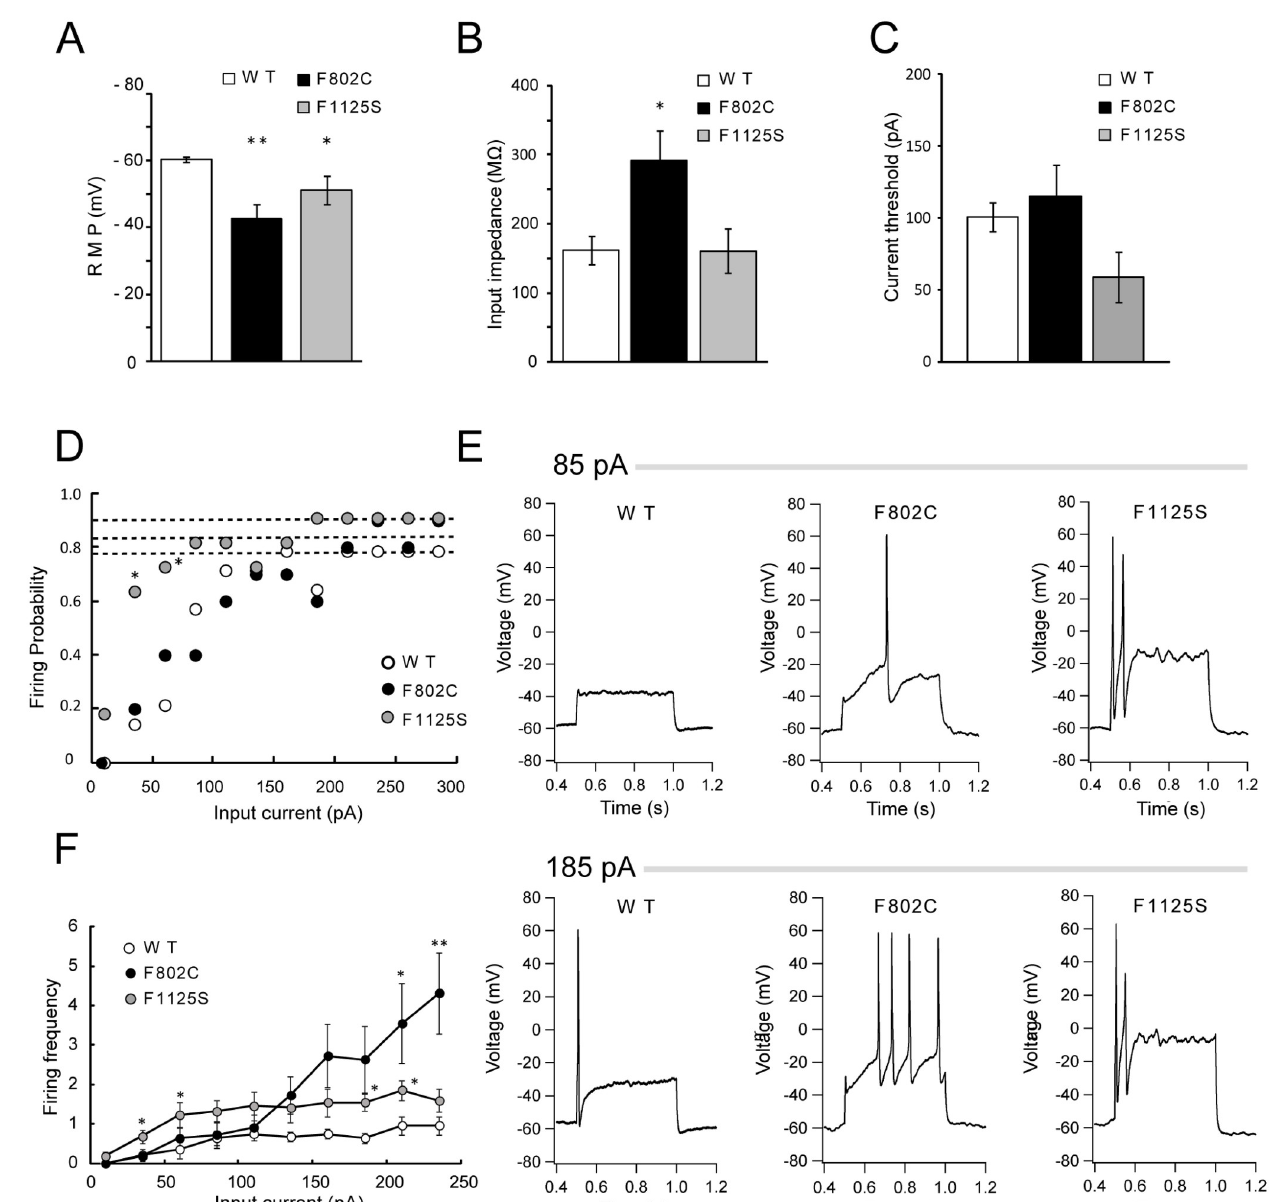
Fig 3. SCN11A mutations (F802C and F1125S) increase excitability in DRG neurons. Knock-in mice harboring the Nav1.9 mutations (F802C or F1125S) significantly depolarized the RMP compared with WT mice (WT, n = 11; F802C, n = 6; F1125S, n = 6). (B) Input impedance was measured at an injection current of 10 pA. F802C mice showed a significant increase in input impedance compared with WT mice (WT, n = 13; F802C, n = 6; F1125S, n = 9). (C) Current threshold was not significant difference among the WT, F802C, and F1125S mice (WT, n = 13; F802C, n = 10; F1125S, n = 11). (D) Comparison of firing probability between WT and each mutation. The maximum firing rate of each cells during current steps of 10–285 pA are represented by the dashed lines (WT, n = 14; F802C, n = 10; F1125S, n = 11). (E) Representative traces of the AP firing, recorded from small DRG neurons ( < 25 μ m) in each mutation (F802C and F1125S), show increases during 500 ms current steps of 85 pA and 185 pA. Upper and lower panels represent the response to input current 85 pA and 185 pA respectively. (F) Comparison of the repetitive number of APs between WT and each mutation (WT, n = 14; F802C, n = 11; F1125S, n =